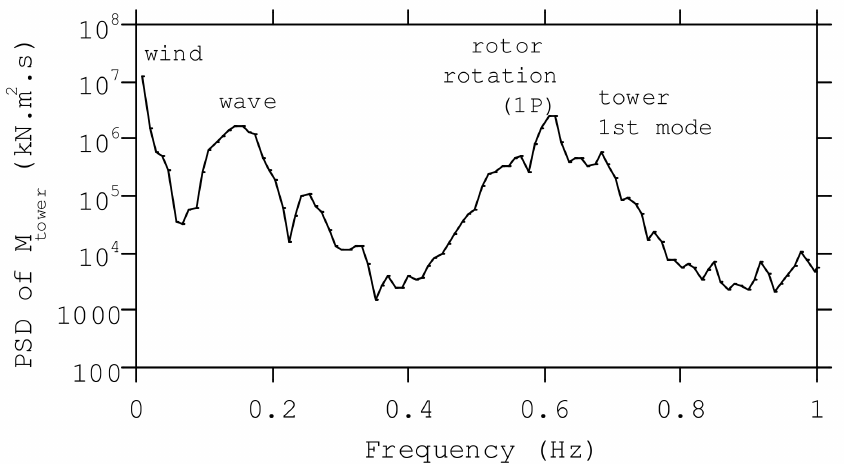
Figure 13. Power spectrum density of the fore-aft tower base moment in extreme sea stated during power